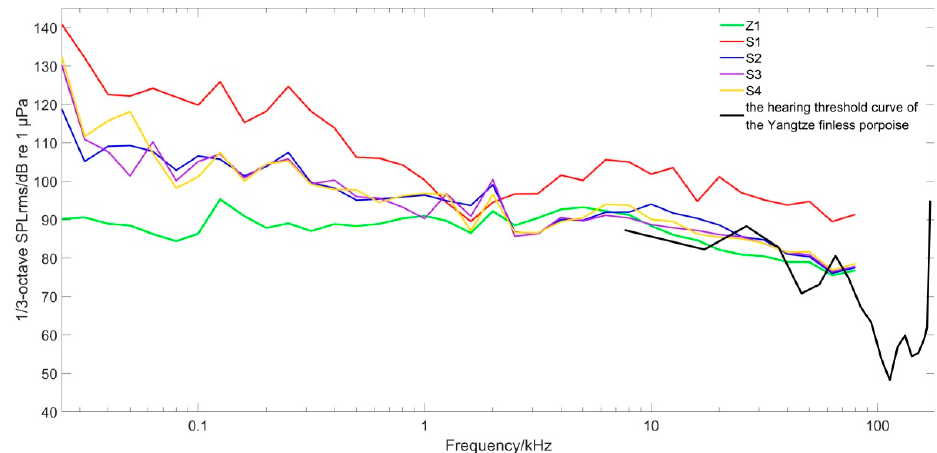
Figure 6. 1/3-octave SPL rms of each sampling point and audiogram of the Yangtze finless porpoise (frequency range 25 Hz − 180 kHz; the porpoise audiogram is reproduced from Popov et al., 2005 [23], with the permission of the Acoustical Society of America ).